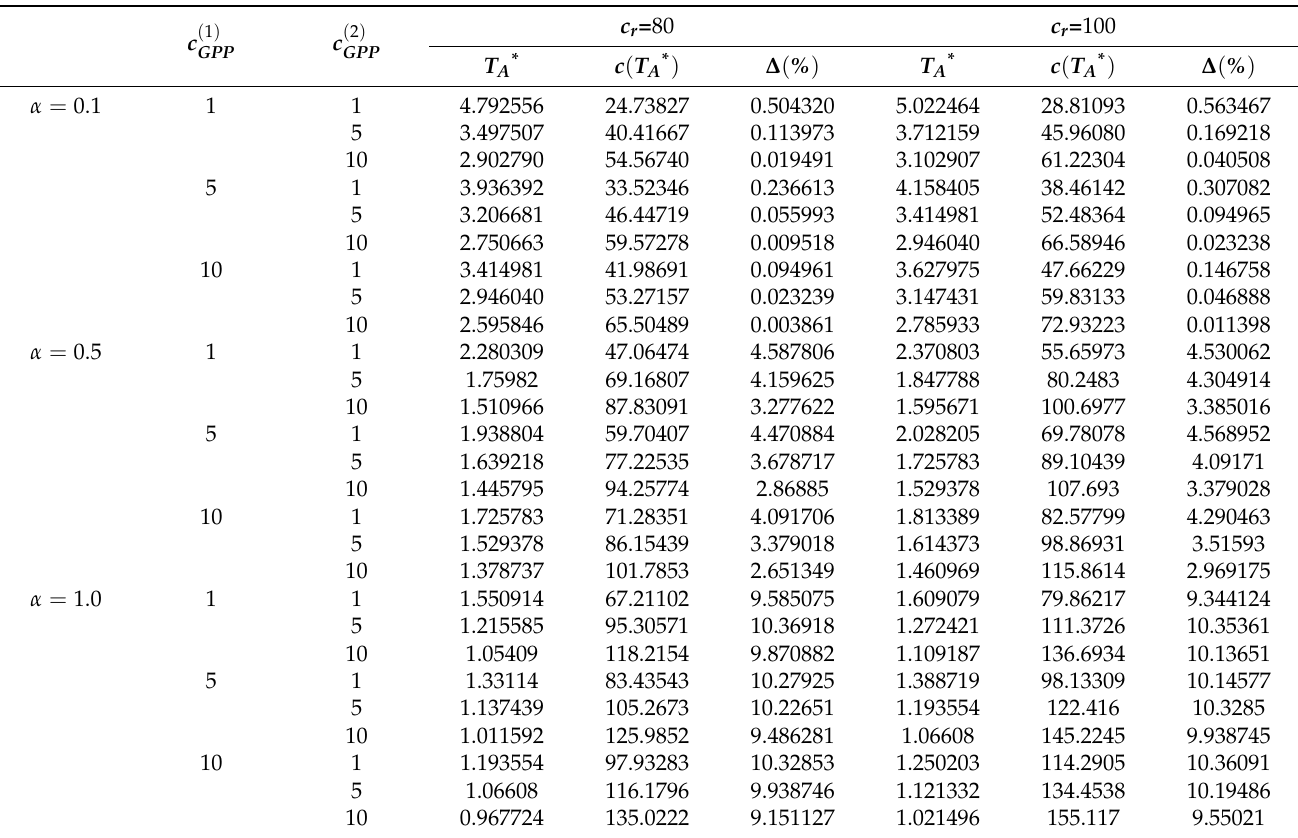
Table 3. The optimal T A ∗ , c ( T A ∗ ) , and ∆ ( % ) for different values of α and c c r =